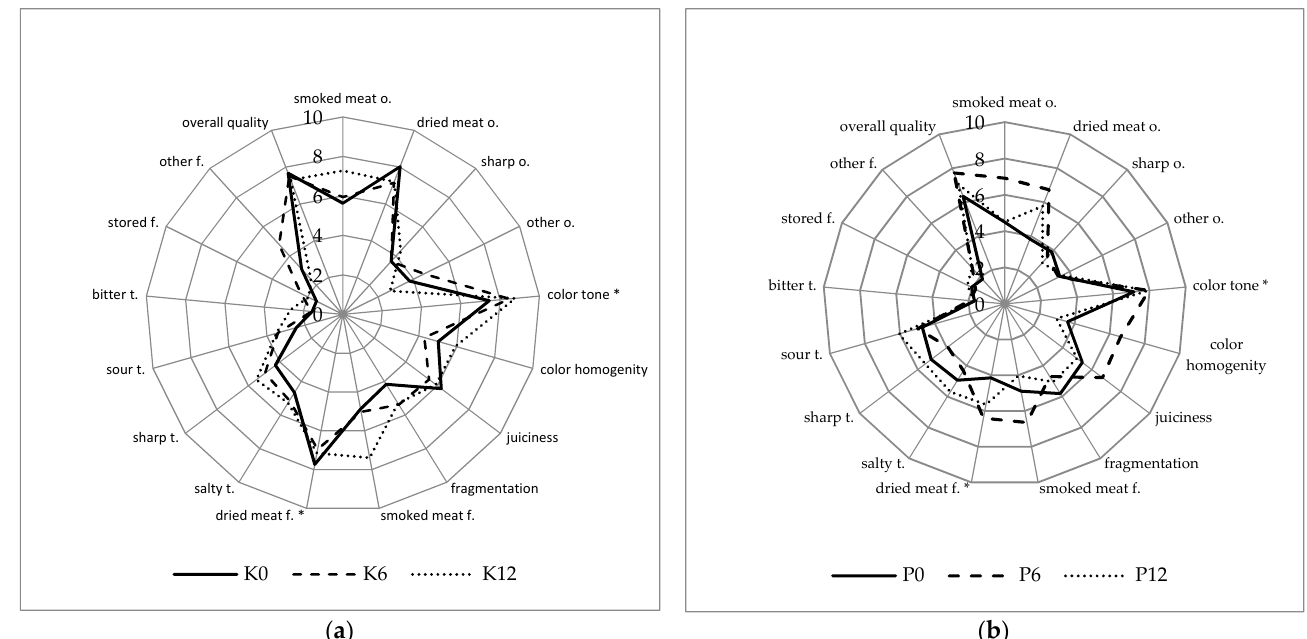
Figure 1. ( a ) Sensory quality characteristics of control dry fermented sausages without L. rhamnosus LOCK900 addition: after ripening process (K0), after 6 (K6), after 12 (K12) weeks of storage; ( b ) Sensory quality characteristics of probiotic dry fermented sausages with L. rhamnosus LOCK900 addition: after ripening process (P0), after 6 (P6) and after 12 (P12) weeks of storage. c—colour, o—odour, f—flavour, t—taste; * Values are significantly different ( α ≤ 0.05).